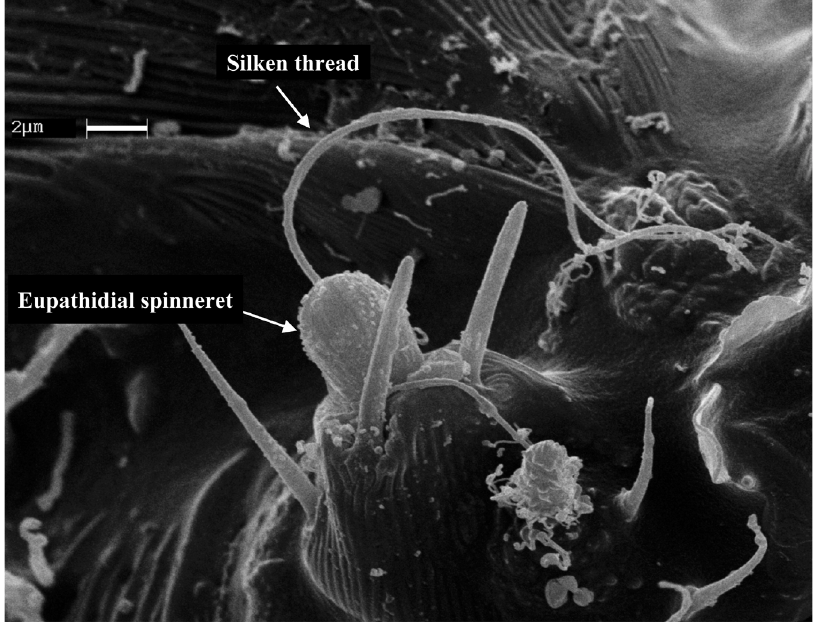
Fig. 3. Pedipalpal tarsus of Tetranychus urticae (Koch).